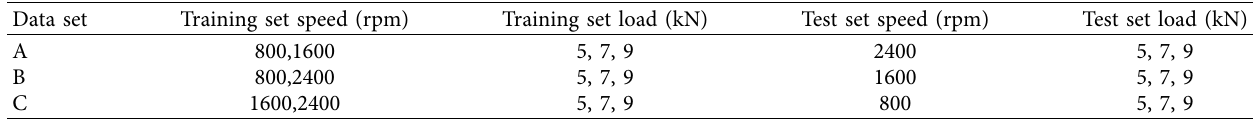
Table 7: Data set of multiple working conditions.